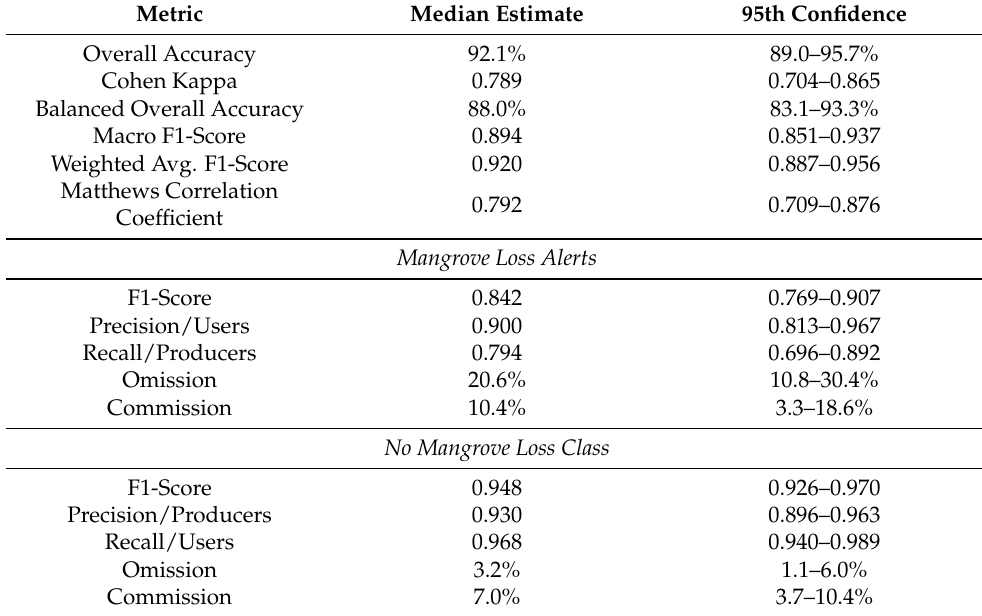
Table 4. The accuracy assessment metrics using the 1 km hexagons to assess the accuracy of the mangrove loss alerts without reference to a mangrove